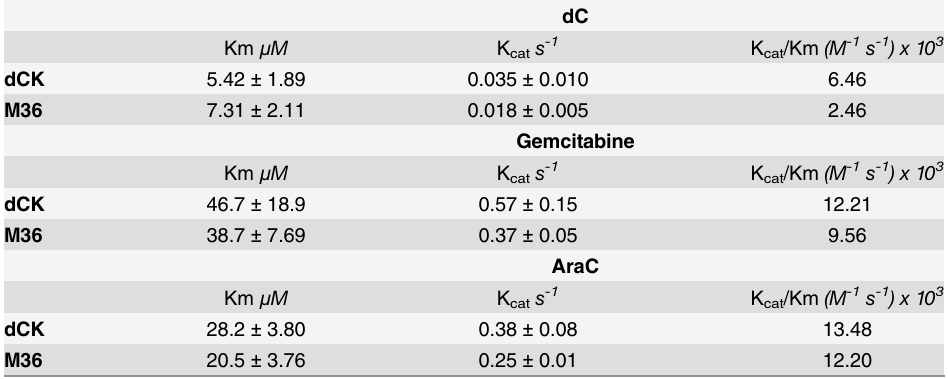
Table 2. Kinetic parameters of the M36 mutant with respect to dC, gemcitabine and